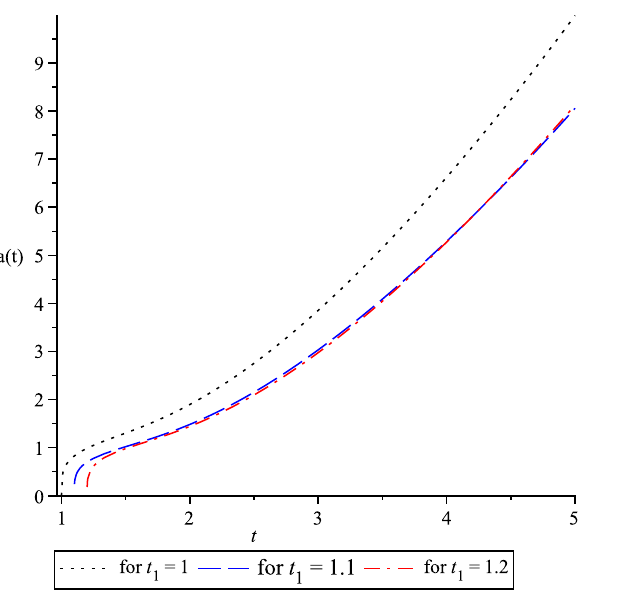
Fig. 2 Graphical representation of variation of the Hubble parameter H vs t for γ = 1